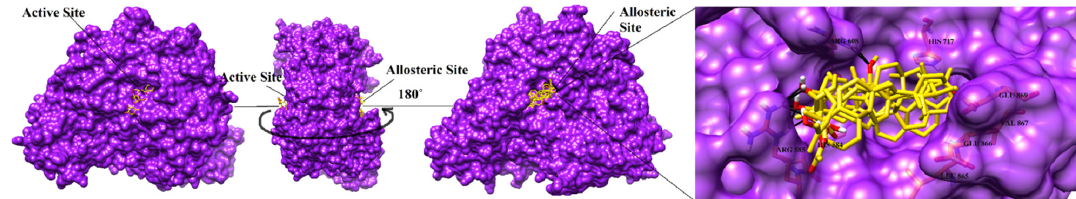
Figure 8. Docked orientations of compounds 3 – 5 and 11 are shown in the Cavity 1. The compounds are shown in purple sticks, hydrogen bonds are presented in black lines.